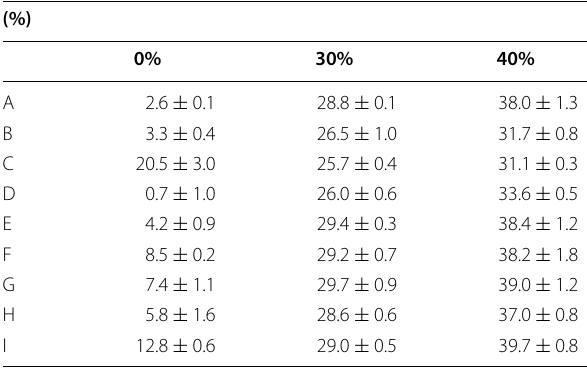
Table 5 ICC at each target value for the asymmetric